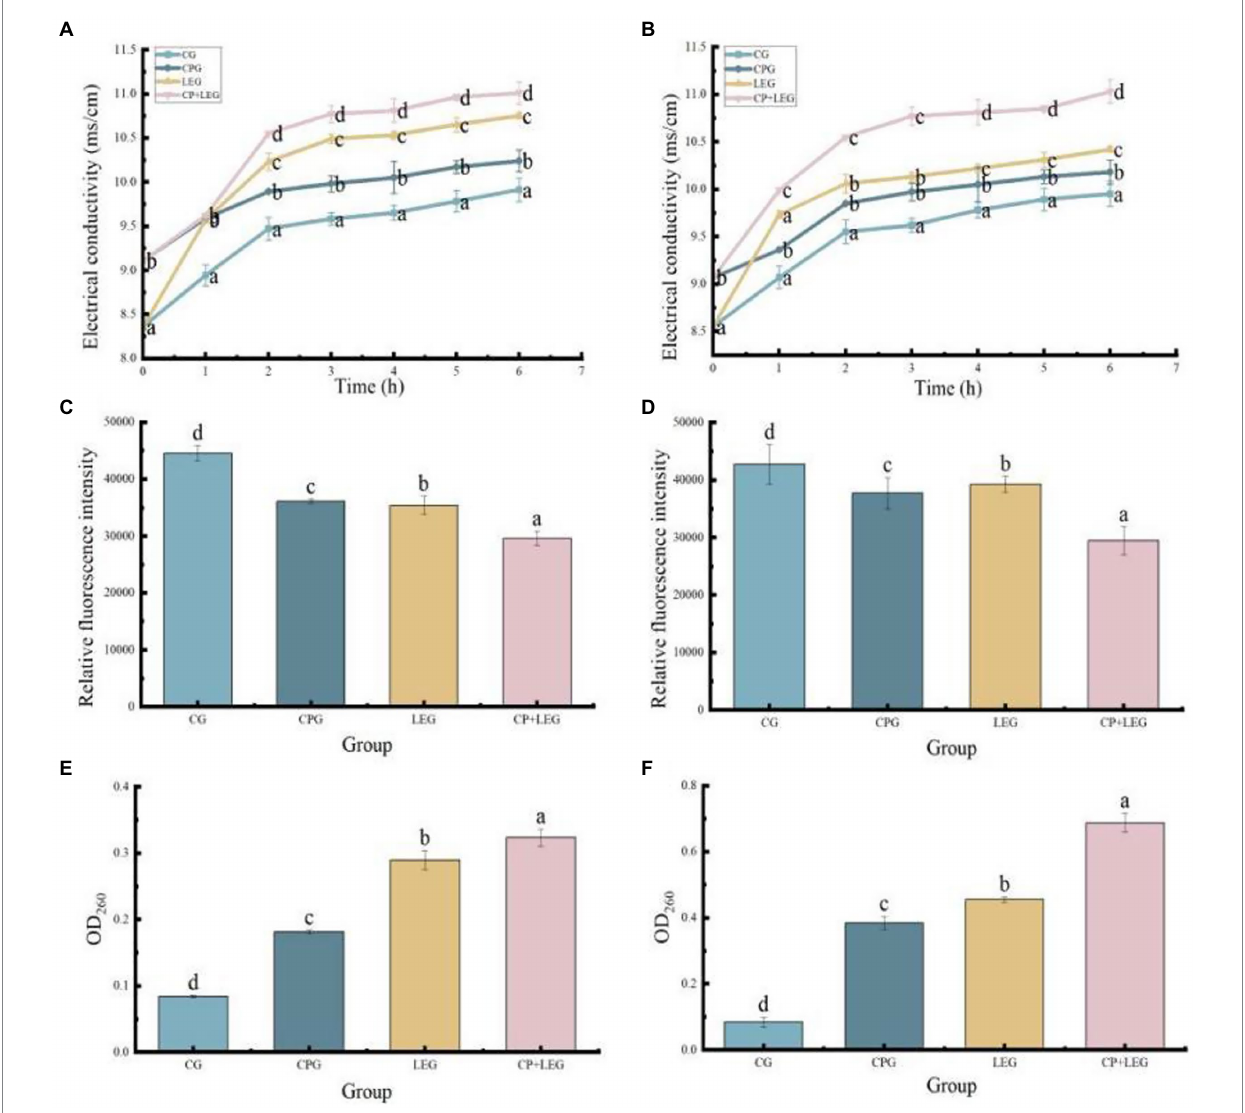
FIGURE 4 Effects of different preservation methods on the cell membrane of bacteria. CG, the control group; CPG, the compound preservative group; LEG, the low voltage variable frequency electric field group; CP+LEG, the compound preservative combined with low voltage variable frequency electric field group. (A,C,E) are Bacillus subtilis ; (B,D,F) are Pseudomonas . Different lowercase letters indicate significant differences between groups ( p < 0.05). Data were obtained as the mean ± standard deviation ( n =